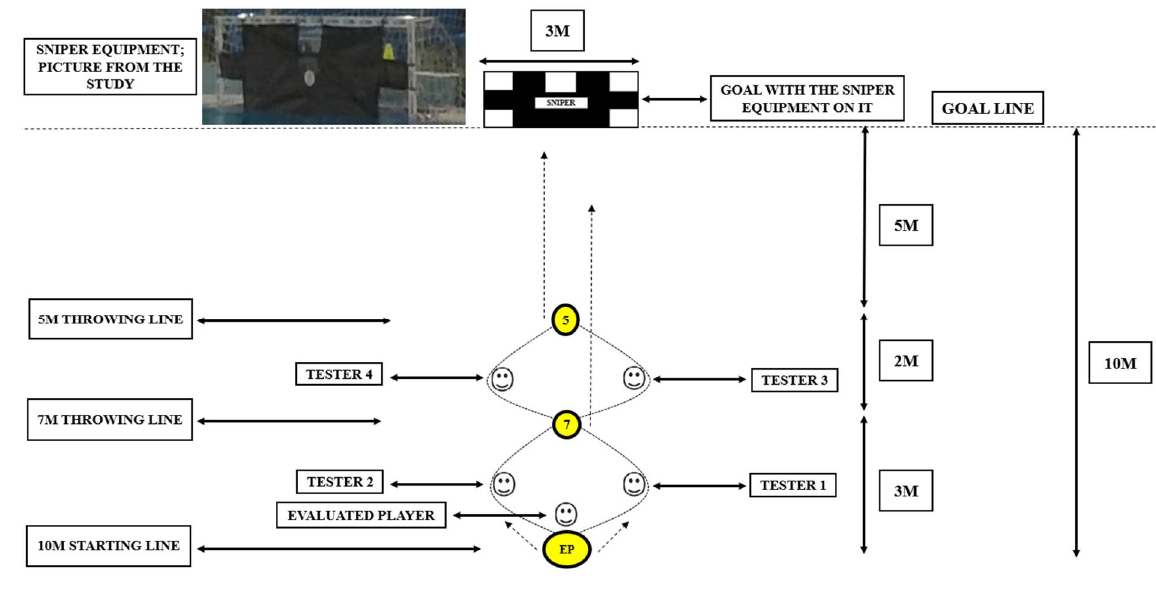
Figure 1. Schematic representation of the Functional Test for Offensive Agility Performance proposed to evaluate water polo players.